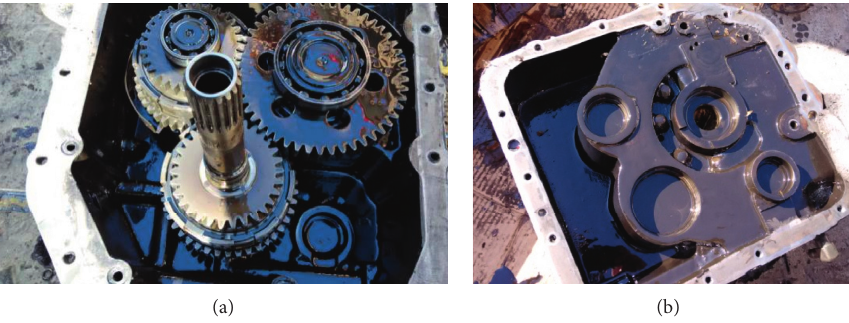
Figure 1: Disassembly process diagram.